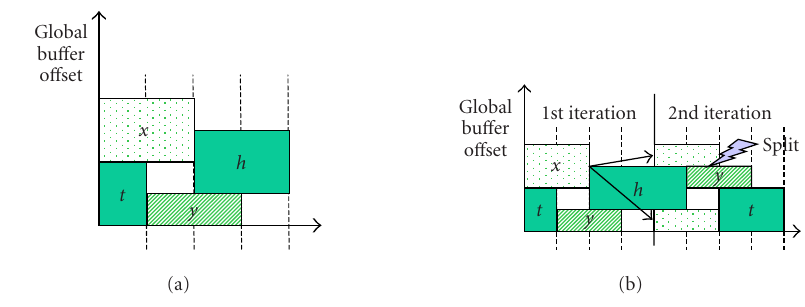
Figure 16: (a) A global bu ff er lifetime chart with di ff erent size samples where t is a tail interval and h is a head interval. (b) Interval x should be split at the second iteration, which is not allowed in the generated code.